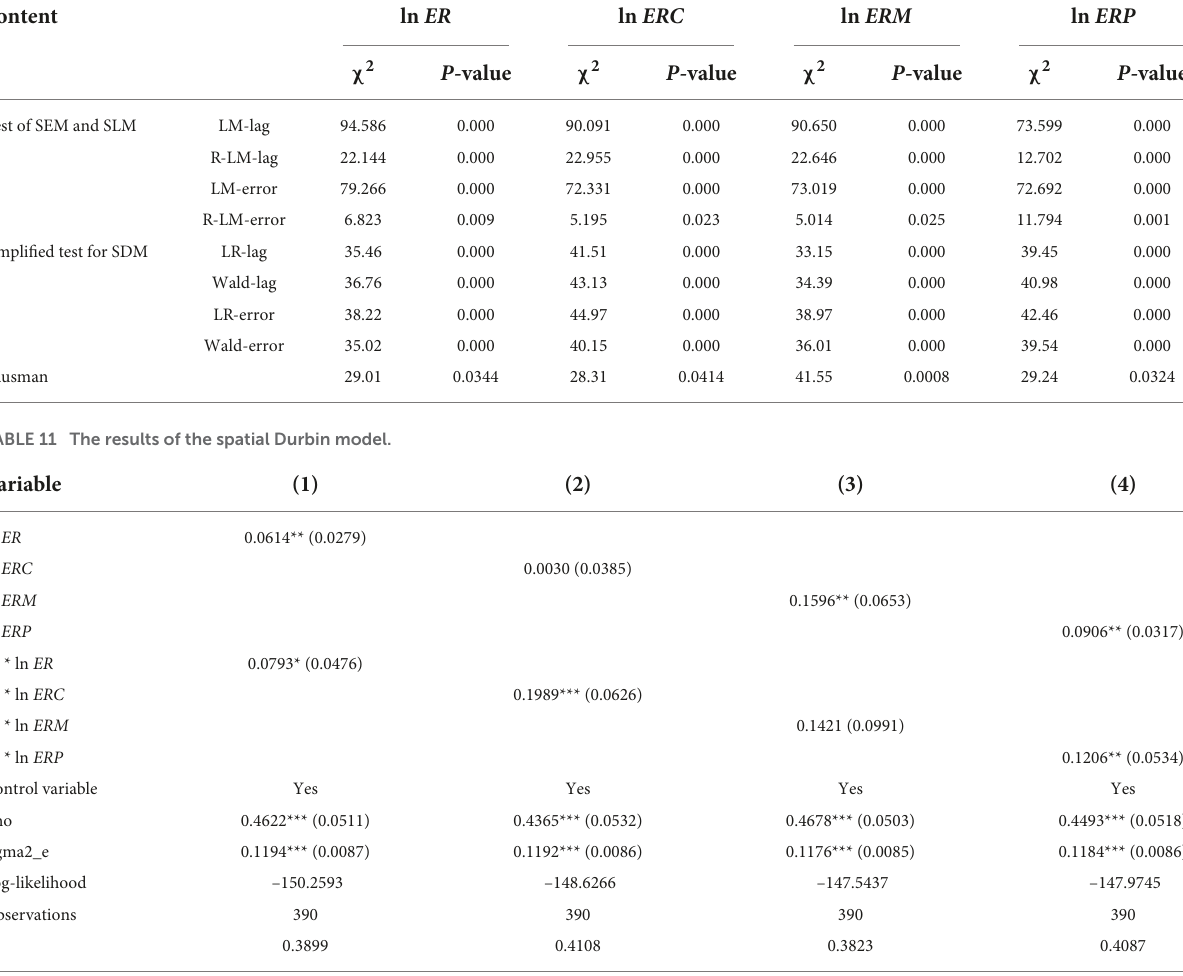
TABLE 10 Identification test of the spatial model.